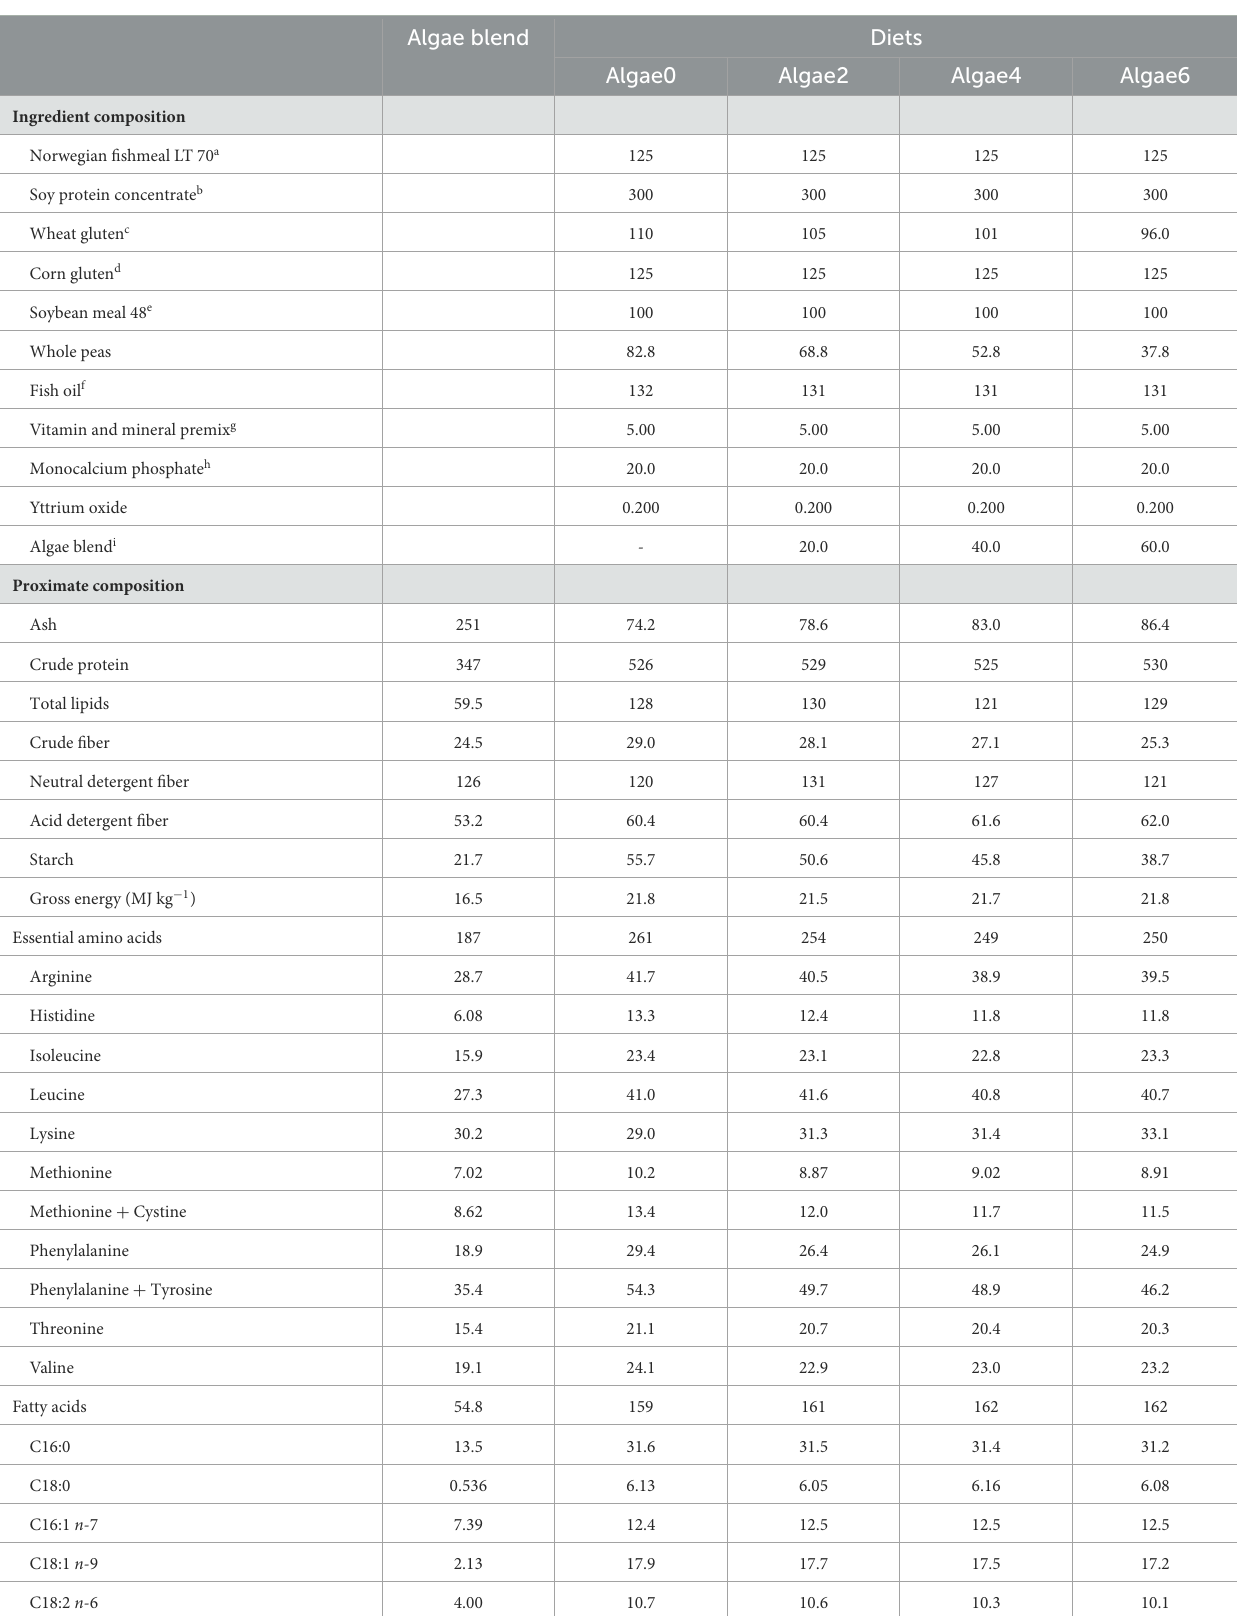
TABLE 1 Ingredient composition (g kg − 1 , as is) and proximate composition, essential amino acids, and selected fatty acids content (g kg − 1 , dry matter) of the algae blend and experimental diets. Algae blend Diets Algae0 Algae2 Algae4